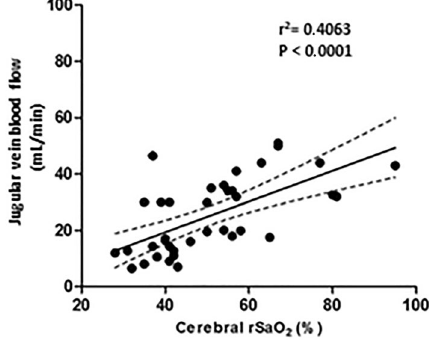
Figure 5. Linear regression between cerebral oxygen saturation (rSaO 2 ) and jugular venous blood fl